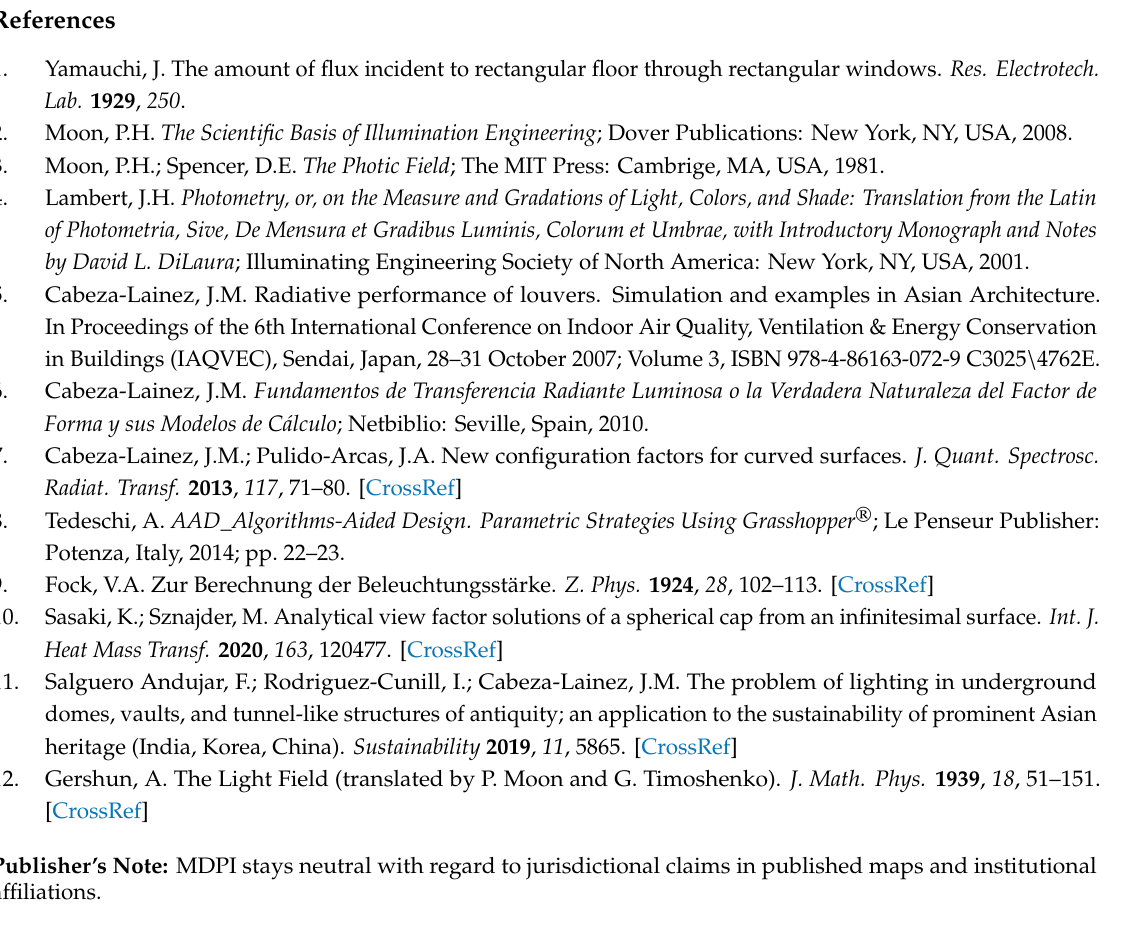
Figure A9. Perspective view of the Tomomi’s Figure A11. Perspective view of the Tomomi’s curve.